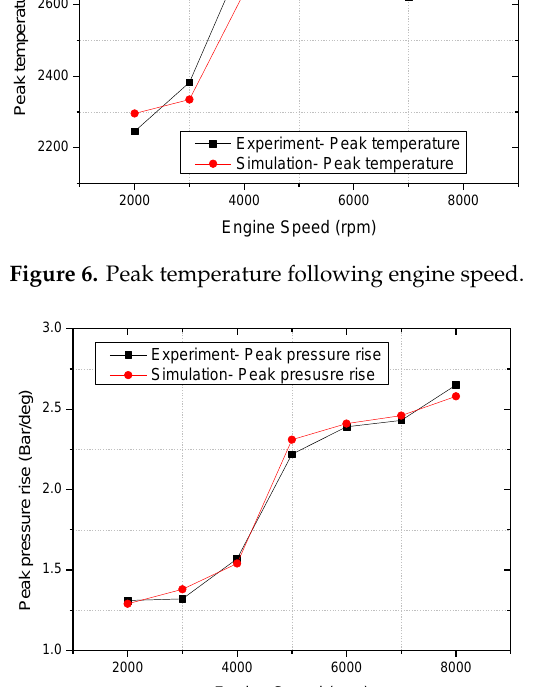
Figure 7. Peak pressure increase following engine speed.